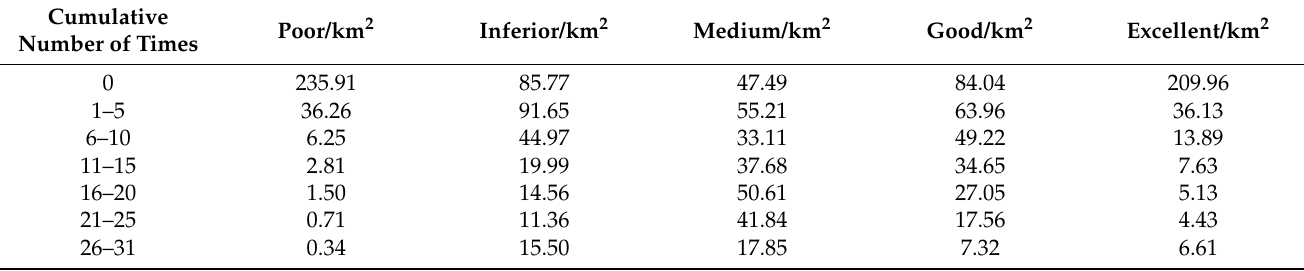
Table 3. Area statistics of cumulative value of ecological quality (EQ) at different levels in 31 years.